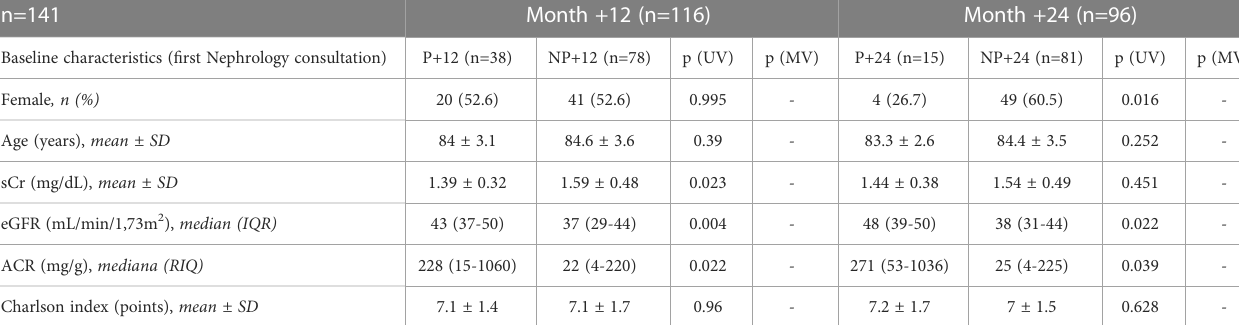
TABLE 6 Progression related factors after 12 and 24 months in initial non-progressors. n=141